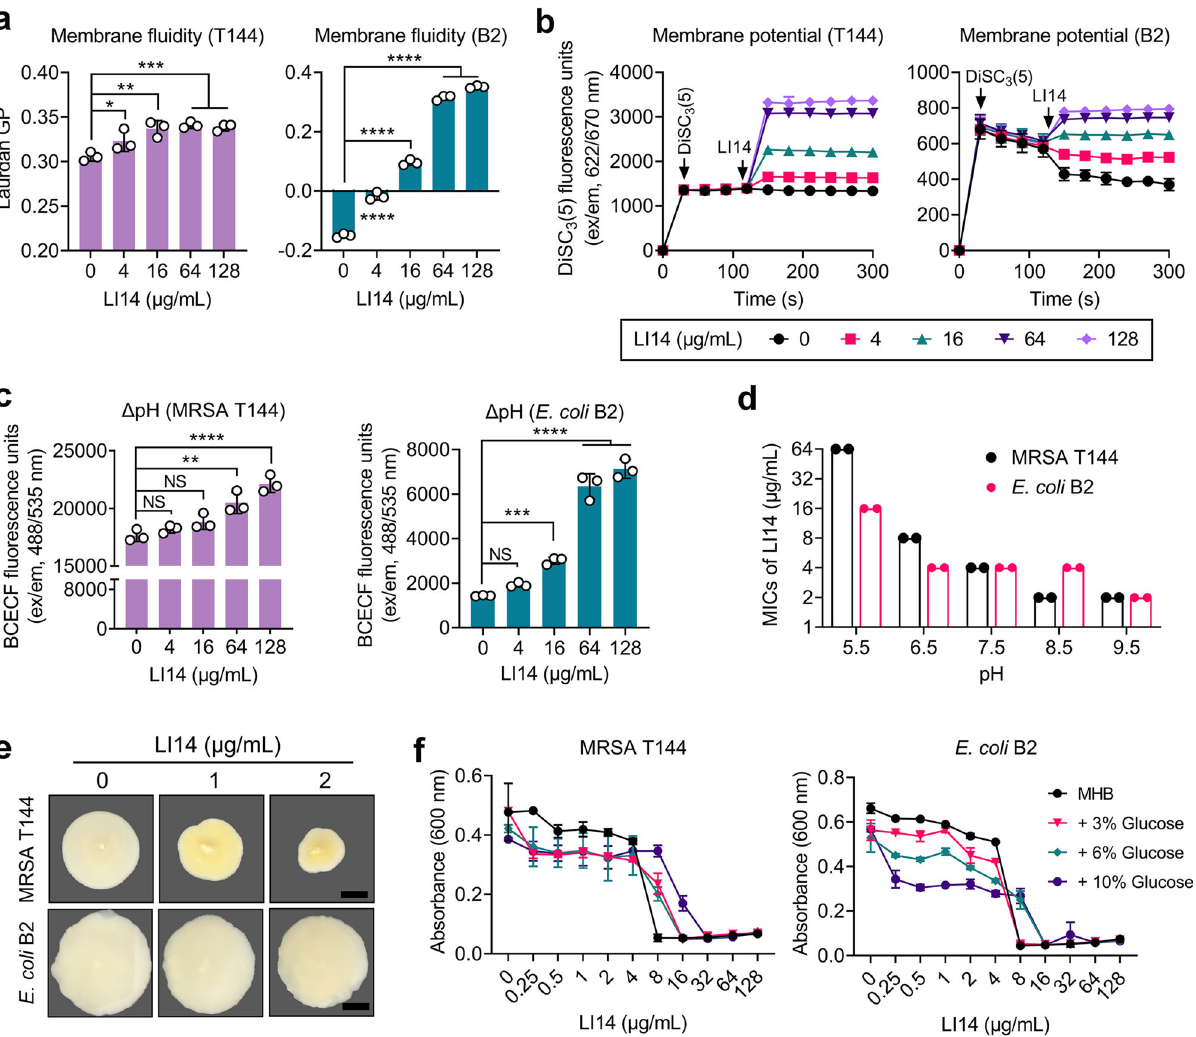
Fig. 4 LI14 peptide dissipates the PMF and boosts the production of ROS. a Membrane fl uidity changes in MRSA T144 and E. coli B2 under exposure of LI14 peptide. Membrane fl uidity was determined using 10 µ M Laurdan, and the fl uorescence intensities were detected with emission wavelengths of 435 nm and 490 nm upon excitation at 350 nm. b LI14 dissipates membrane potential both in MRSA T144 and E. coli B2 in a manner of dose-dependent. A fl uorescence probe DiSC fi nal concentration, 0.5 μ M) was injected at 30 s followed by self-quenching and stabilization, then varying concentrations 3 (5) (